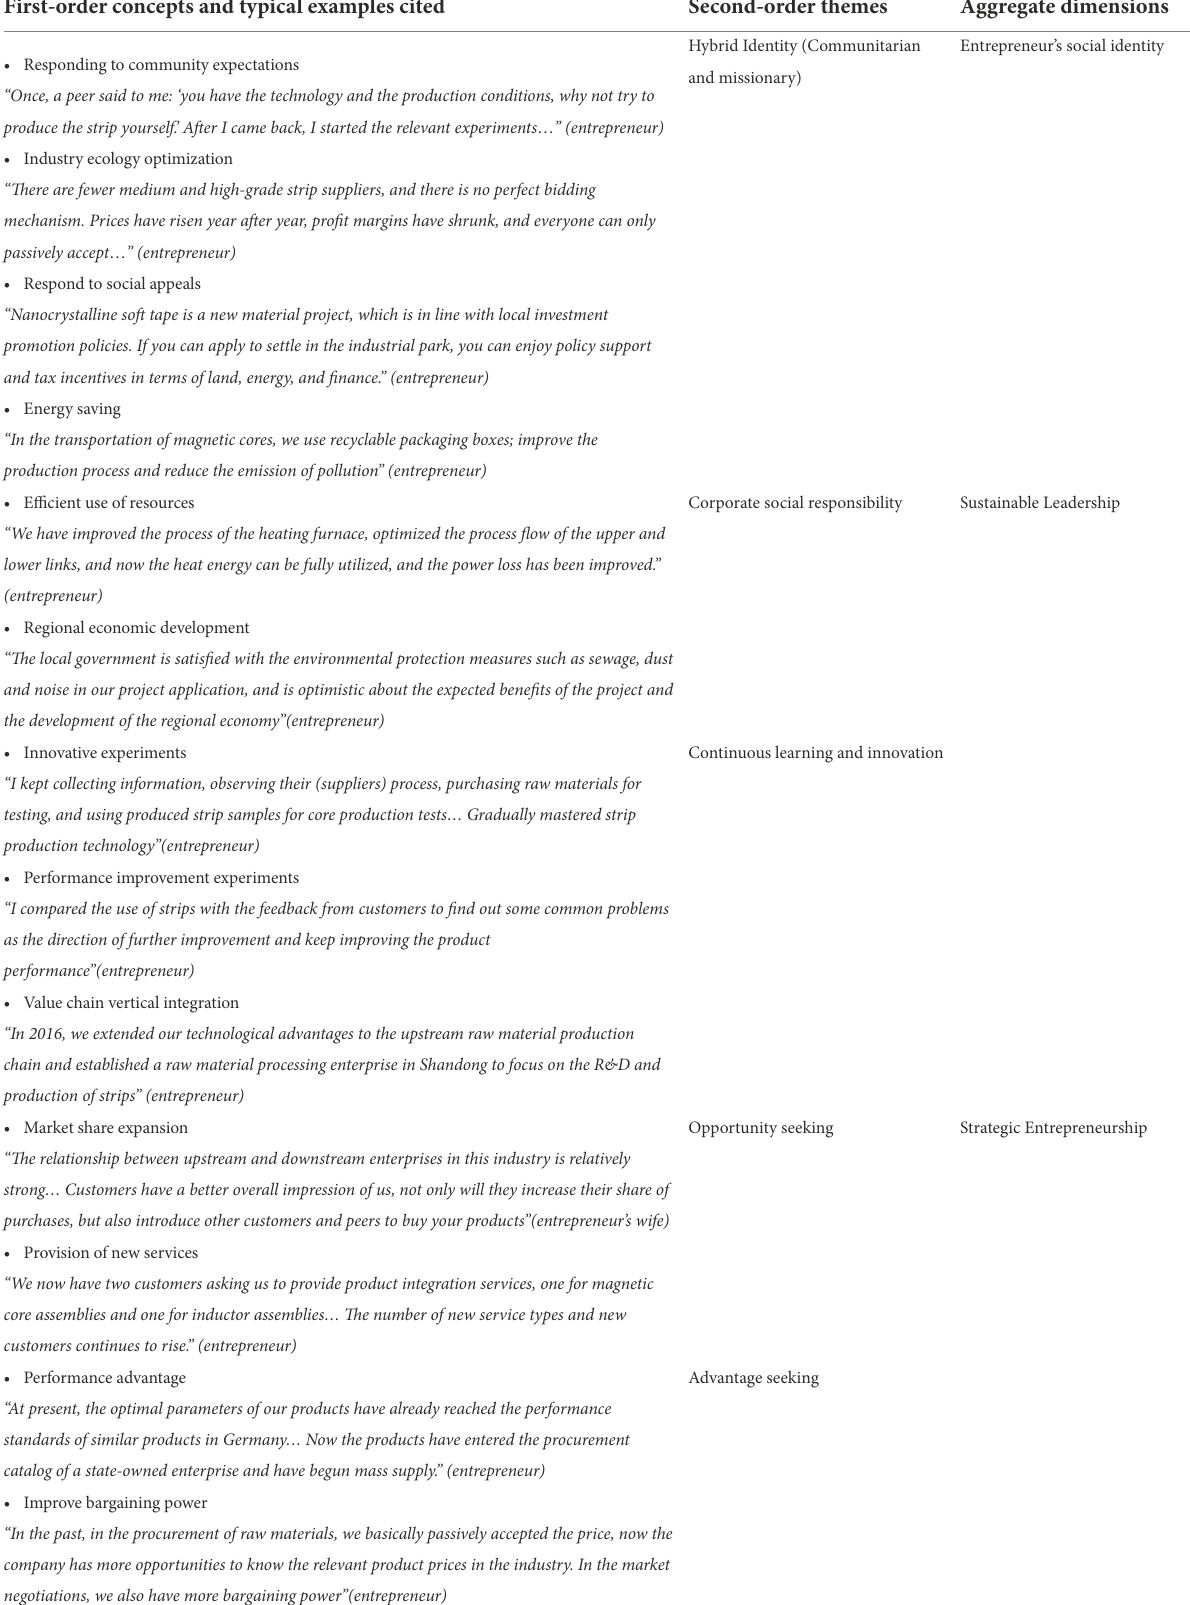
TABLE 6 Typical examples and coding results for the expansion stage (partial). First-order concepts and typical examples